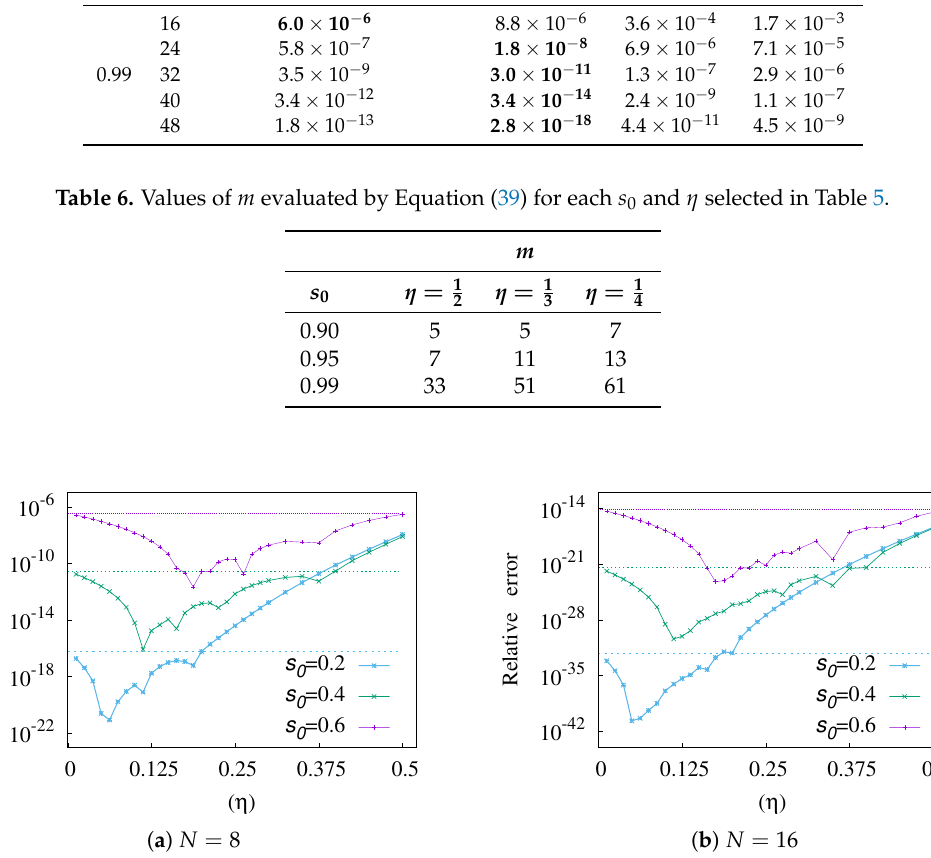
Figure 6. Relative errors of F ( η ; t ) , 0 < η < 1 , for the CPV integral K φ ( s 0 ) , for s 0 = 0.2,0.4,0.6, in Example 3. 2 Dotted horizontal lines indicate relative errors of Q DG ( t ) corresponding to the chosen values of s 0